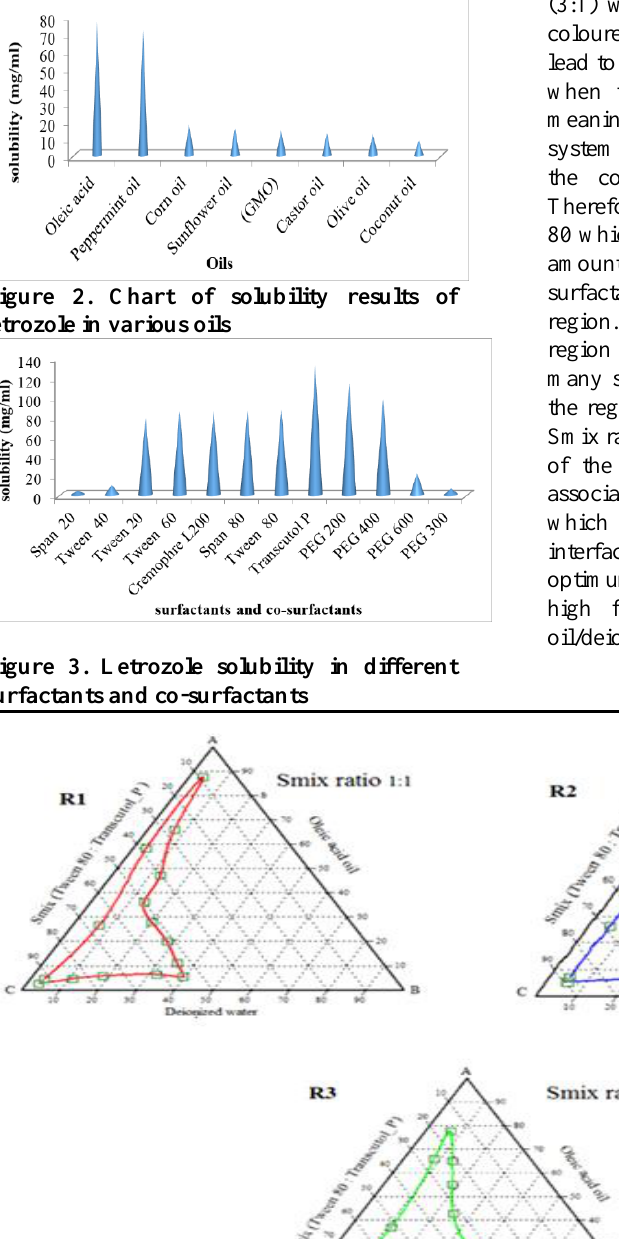
Figure 2. Chart of solubility results of letrozole in various oils